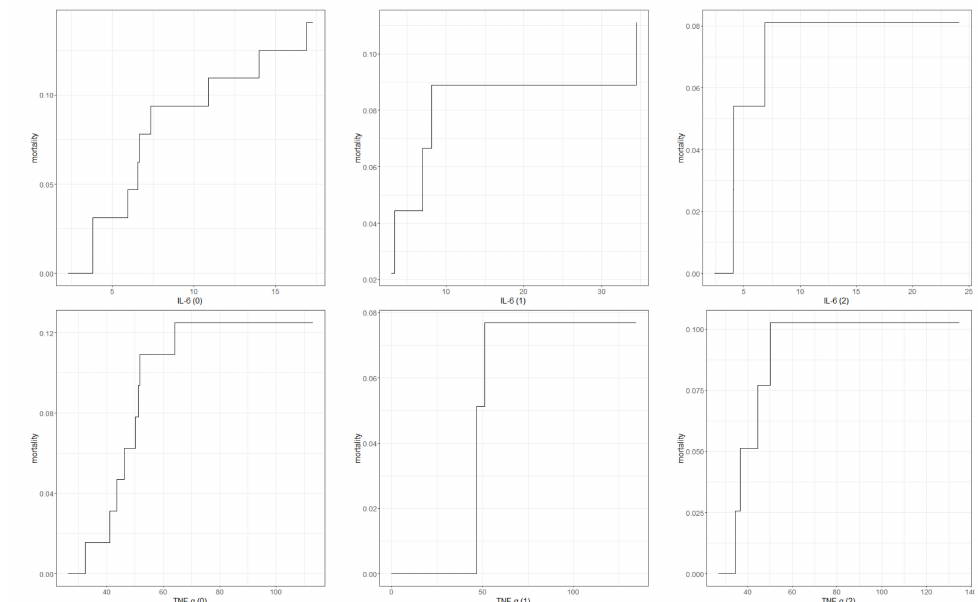
Figure 5. The percentage of deaths among patients after stroke with an increase in the biomarker value. Abbreviations: IL-6 (0)—interleukin 6 within 4.5 h; IL-6 (1)—interleukin 6 within 24 h; IL-6 (2)—interleukin 6 within 7 days; TNF- α (0)—tumour necrosis factor within 4.5 h; TNF- α (1)—tumour necrosis factor within 24 h; TNF- α (2)—tumour necrosis factor within 7